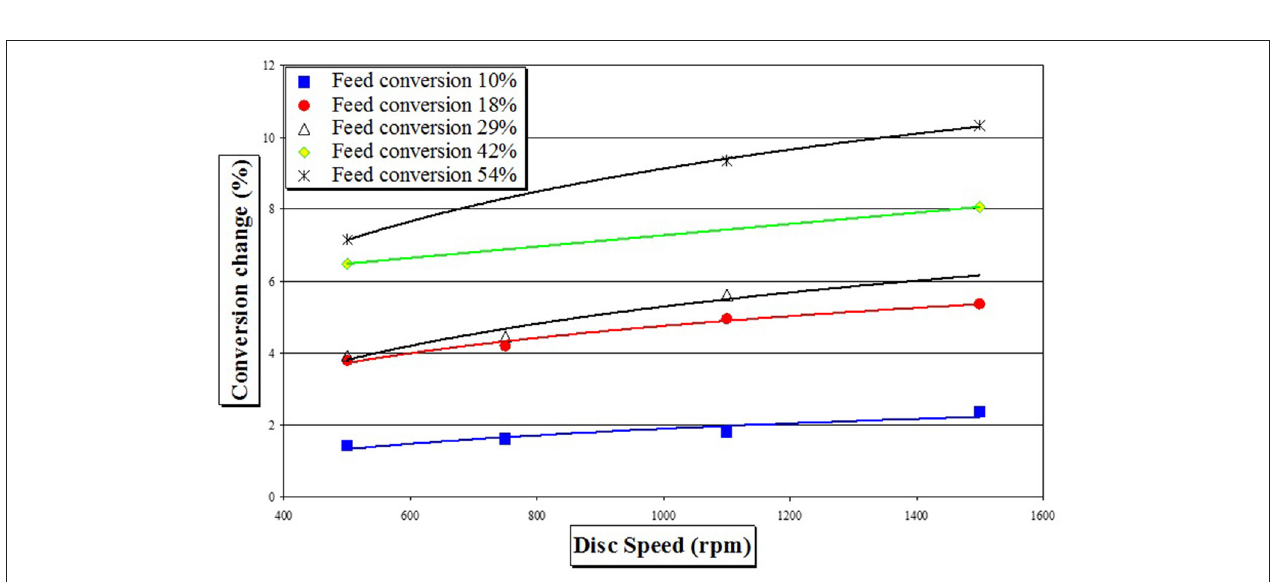
FIGURE 1 | Schematic of the Spinning Disc Reactor